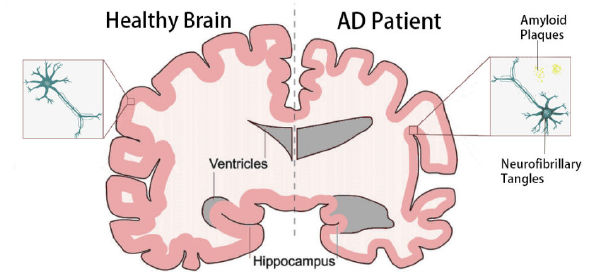
Figure 1. Difference between healthy brain and AD (Alzheimer’s disease) patients (adapted from ref [6]).